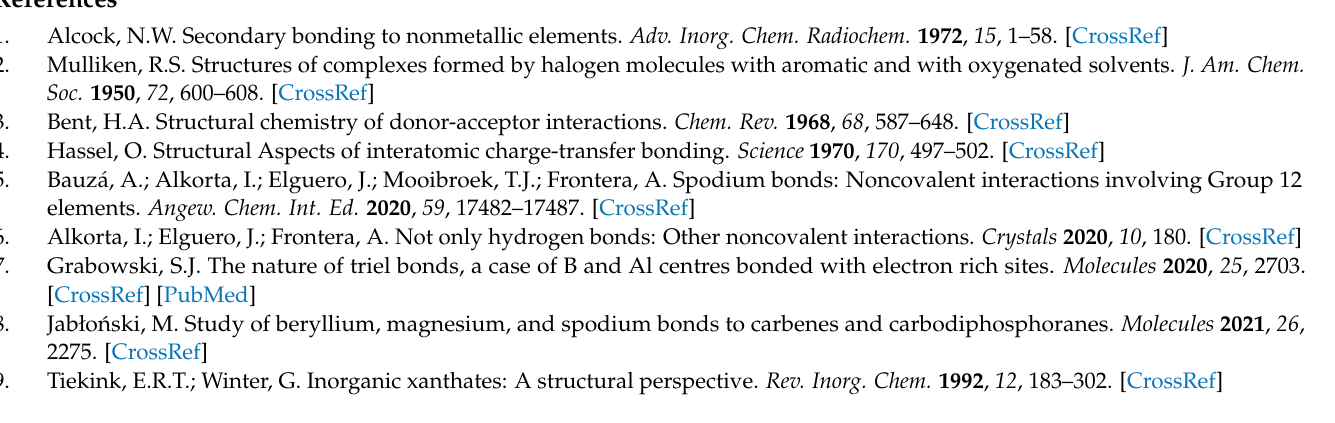
Figure S38. LENZIN (Diethyldithiophosphinato-S)-phenyl-mercury(II); Figure S39. QIQHIH (2- mercury(II); Figure S41. WAYPAN Trimethyl-( µ 3-1,1,1-tris(mercaptomethyl)ethane-S,S (cid:48) ,S (cid:48)(cid:48) )-tri-mer- cury(II); Figure S42. OBIZAC (1,5-bis(2-Methoxyphenyl)thiocarbazonato)-phenyl-mercury(II); Figure S43. NESRUA (N'-Benzylidene-N,N-dimethylcarbamohydrazonothioato)-(methyl)mercury(II); Figure S44. DOYFIG Methyl-(2-mercapto-4-methylpyrimidinato)-mercury(II); Figure S45. QUGVIX (3-Aminophenylthiolato)-phenyl-mercury(II); Figure S46. DOFNOC Ethyl-(phenylthiolato)-mercury- (II); Figure S47. YOMXIJ (( µ 2-(2-furylmethyl)(4-(((2-furylmethyl)((sulfanyl)(thioxo)methyl)amino)m- ethyl)-benzyl)carbamodithioato)-diphenyl-di-mercury; Figure S48. XUHREY01 Ethyl-(2-carboxybe- nzenethiolato)-mercury(II); Figure S49. PHGMSP Phenylmercury-(2,6-dimethyl-thiophenolate); Figure S50. OCOLEY (4,5-Diphenyl-(1,2,4)triazine-3-thionato)-methyl-mercury; Figure S51. LAWTUB Phenyl(phenylmethanethiolato)mercury(II); Figure S52. GILNOE bis(Methylene(diphenyl)thiophos- phinate)-mercury(II); Figure S53. CHMEHG ( µ -trans-Cyclohexane-1,2-dithiolato)-bis(methyl-mercu- ry(II)) 1980; Figure S54. LOPGUT ( µ 2-2,4-Pyrimidinedithiolato)-diphenyl-di-mercury(II); Figure S55. FUPFOM ( µ 2-N,N'-(1,3-dimethylphenylene)-bis(ferrocenylmethyldithiocarbamato))-bis(phenyl-mer- cury) diethyl ether solvate; Figure S56. CECWOW 8-Mercaptoquinolinato-phenyl-mercury(II); Figure S57. IHOLEW01 (2-Aminocyclopent-1-ene-1-carbodithioato)-methyl-mercury(II); Figure S58. QUGVOD (3-(o-Hydroxybenzylideneamino)phenylthiolato)-methyl-mercury(II); Figure S59. DOFNIW Methyl-(phenylthiolato)-mercury(II); Figure S60. IHOLIA (2-Aminocyclopent-1-ene-1-carbodithioato)- phenyl-mercury(II); Figure S61. EBUSIF Phenyl-(benzyl(pyridin-4-ylmethyl)carbamo- dithioato)- mercury(II); Figure S62. COCJUC catena-(bis( µ -Pyridin-4-yl)-bis(O,O'-di-isopropyldithiophosphato)-